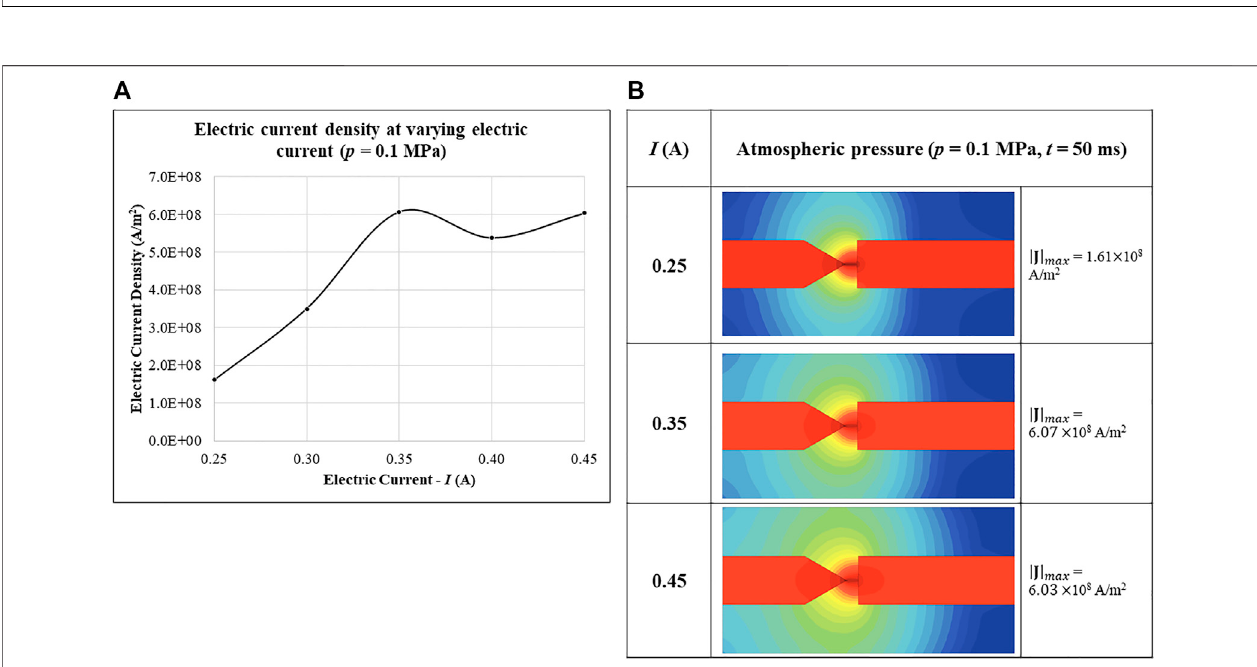
FIGURE14|(A) Electriccurrent density inthe x axis direction atthecenterofthe inter-electrodegap forvaryingcurrent( t (cid:2) 50 ms, p (cid:2) 0.1 MPa), (B) Images ofthe electric current density at varying current; ( t (cid:2) 50 ms, p (cid:2) 0.1 MPa).